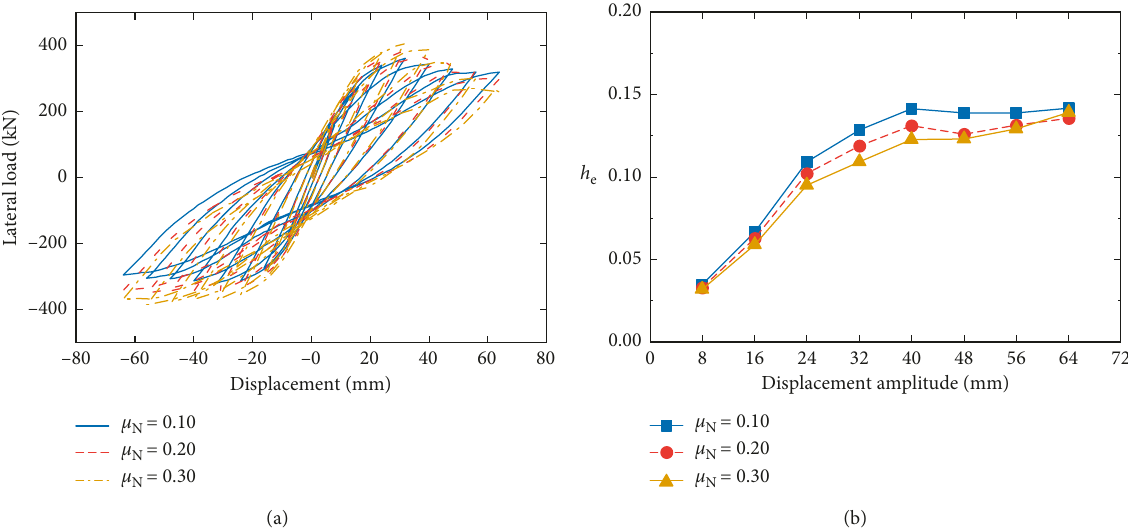
Figure 22: Effect of the axial compression ratio of the wall pier. (a) Hysteresis curves. (b) Equivalent viscous damping